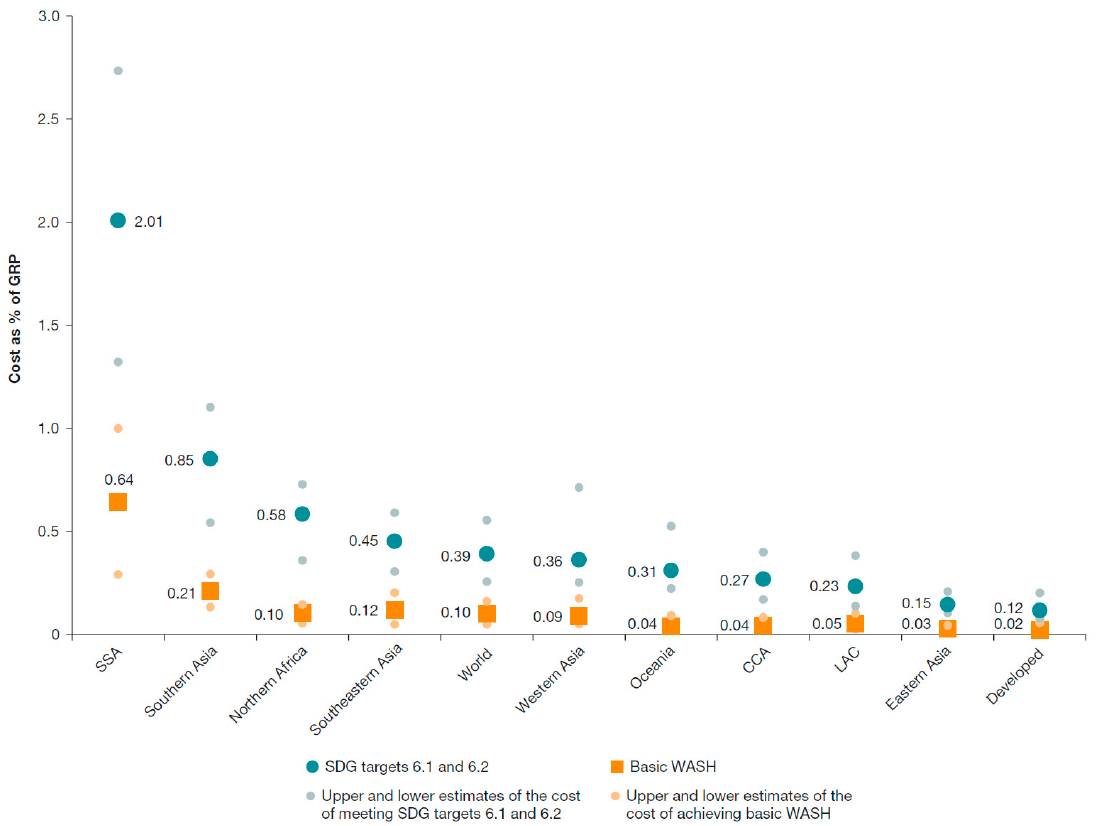
Figure 5. Costs of basic and safely managed services as percentage of gross regional product (GRP) by MDG region, with uncertainty range. Reproduced with permission from the World Bank [126]. Note: WASH = water, sanitation, and hygiene; SDG = Sustainable Development Goal; SSA = Sub-Saharan Africa; LAC = Latin America and the Caribbean; CCA = Caucasus and Central Asia. Gross regional product is based on the aggregated GDP of countries in each region. An economic growth rate of 5 percent is assumed all regions. Lower and upper bounds were based on three significant sources of uncertainty: (1) 100 percent of population using low-cost technology to 100 percent using high cost technology (baseline 50% each); (2) discount rate varied from 3 percent to 8 percent (baseline 5%); and (3) alternative method of transferring cost data to countries with limited unit cost data, using absolute U.S. dollar values instead of adjusting taking into account differences in purchasing power.